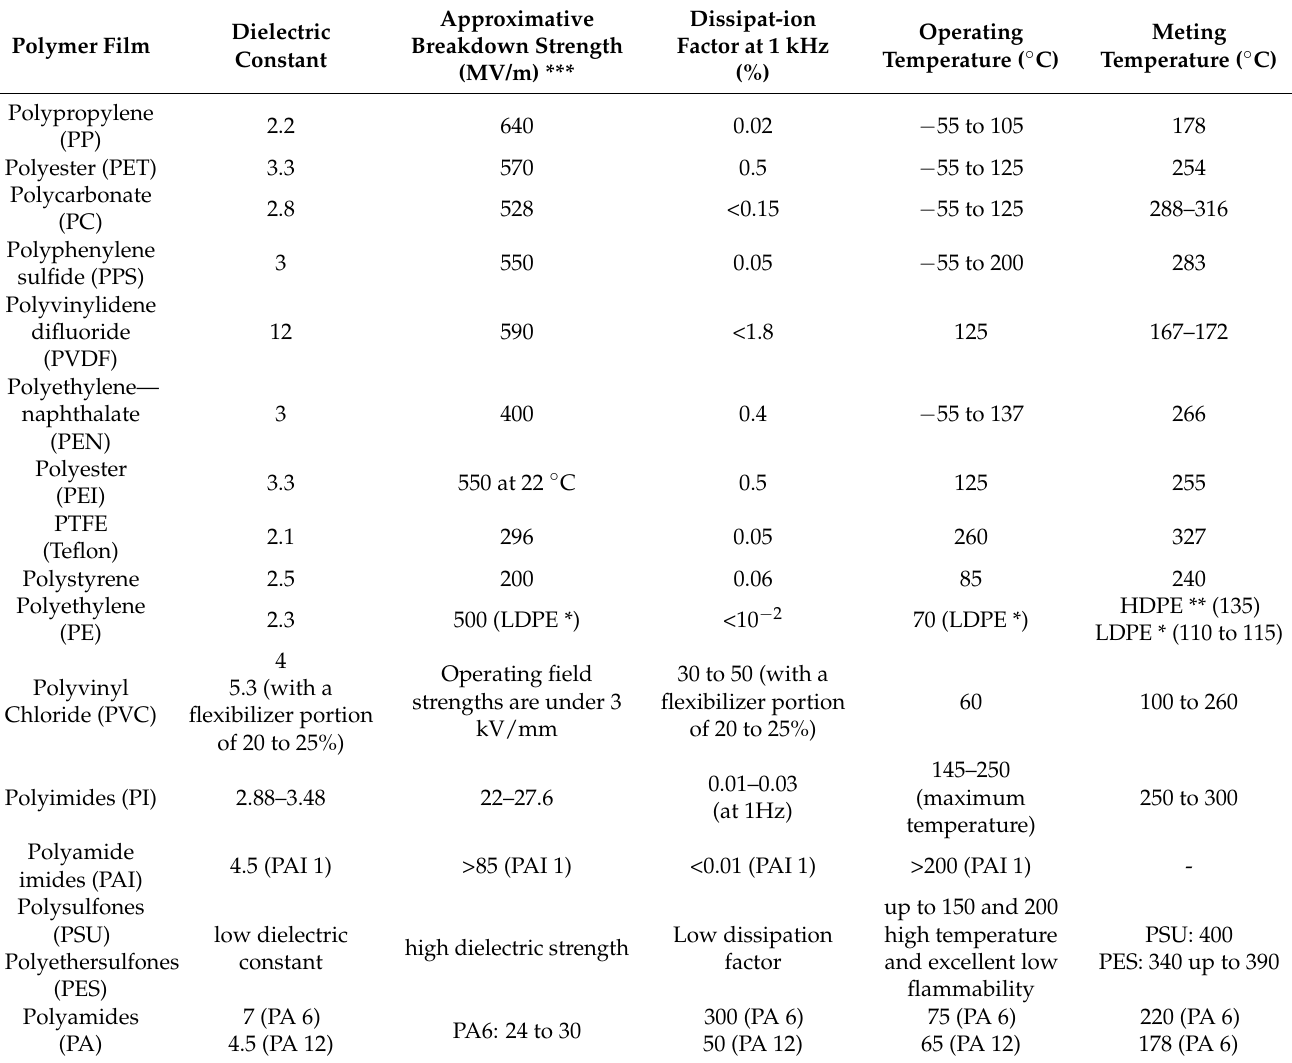
Table 5. Summary of general characteristics of common dielectric polymer films